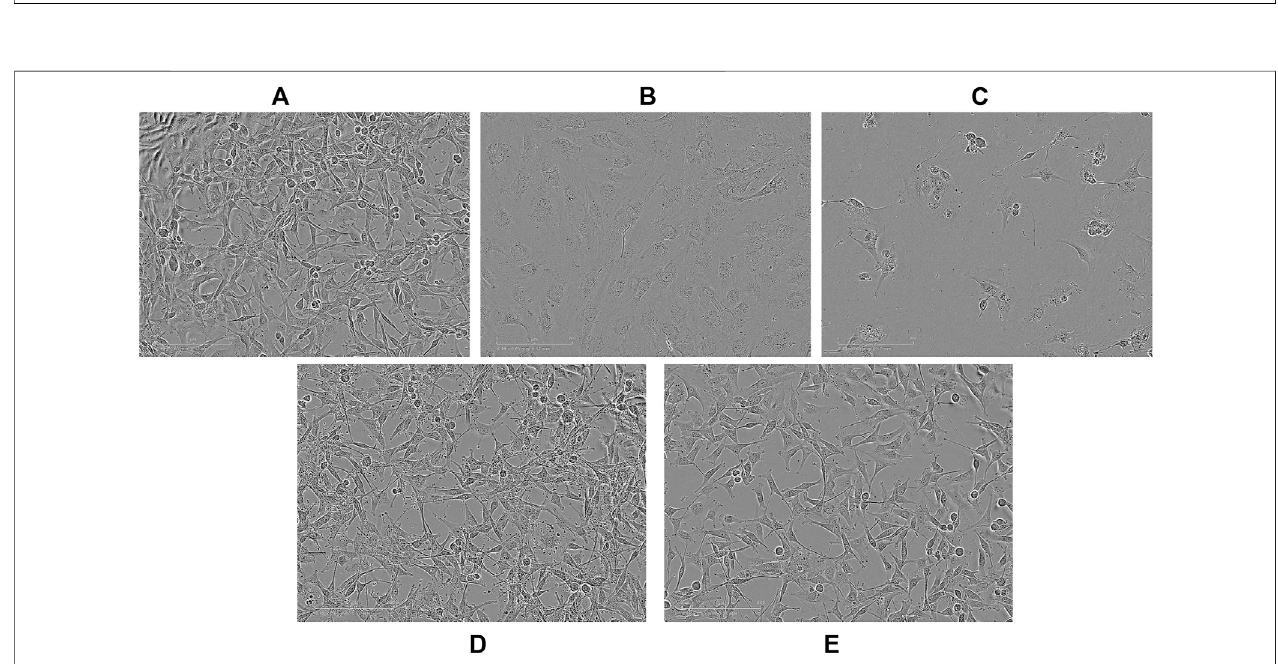
FIGURE 3 | Representative images observed with an optical microscope of U87 cells after 96h of treatment. Controls (A) ; ssAPT 25 µM (B) ; APTSAP 20 nM (C) ; APTSAPKQ 20 nM (D) ; pBlue_SAP 20 nM (E) .